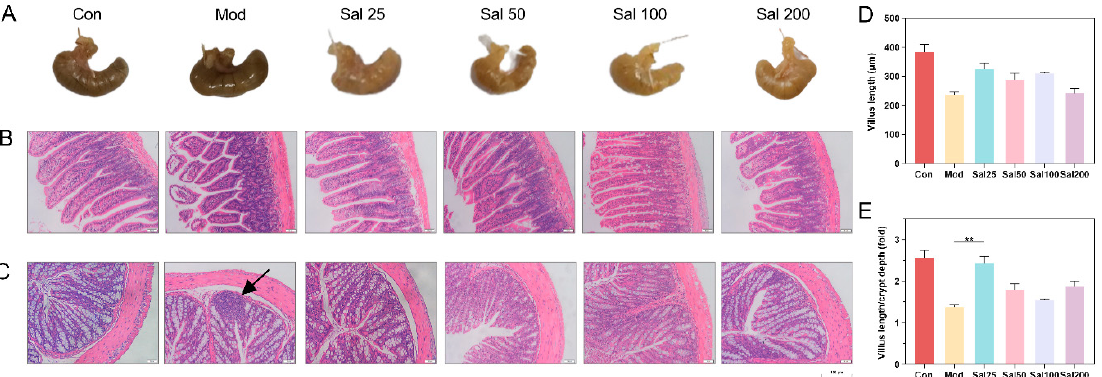
Figure 2. The effects of salidroside on mice intestinal damage. ( A ) Cecum tissues. ( B ) Ileum tissues. ( C ) Colon tissues. Scale bars indicate 150 µm. The black arrow indicates inflammatory infiltration. Histological analysis of the villus length ( D ) and the ratio of villus length to crypt depth ( E ).